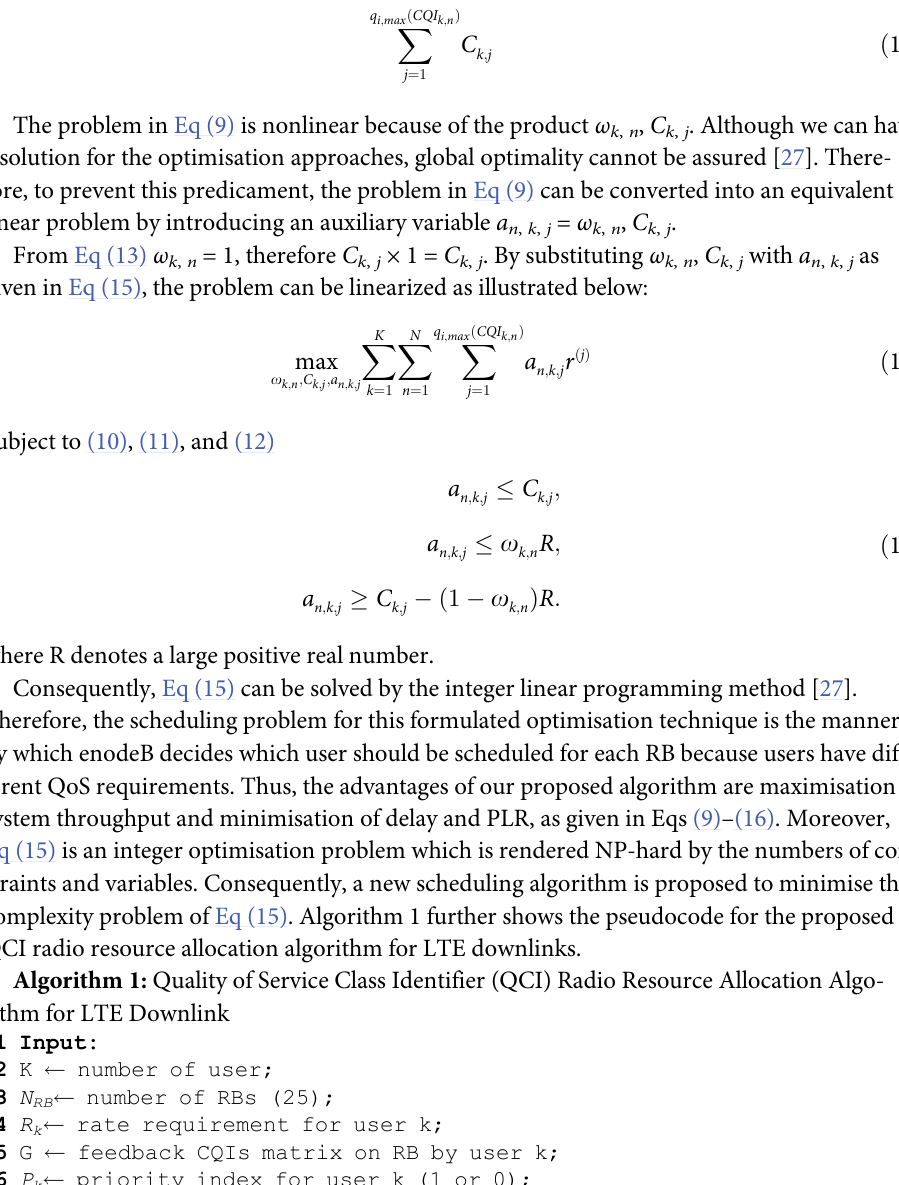
Algorithm 1: Quality of Service Class Identifier (QCI) Radio Resource Allocation Algo- rithm for LTE